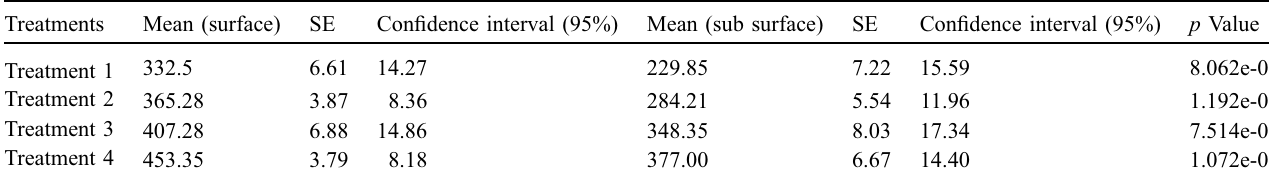
Table 1. Mean counts and abundance of periphyton (no./cm 2 /day) in surface and subsurface waters of ponds under different treatments. Treatments Mean (surface) SE Con fi dence interval (95%) Mean (sub surface) SE Con fi dence interval (95%) p Value Treatment 1 Treatment 2 Treatment 3 Treatment